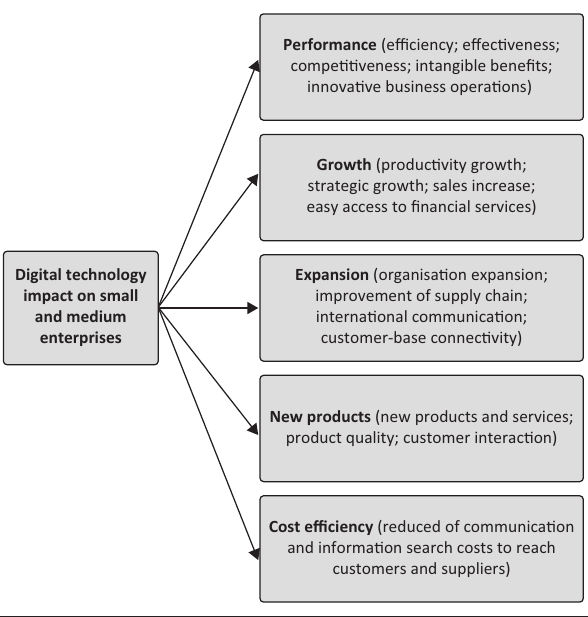
FIGURE 1: Impact of digital technologies on small and medium enterprises business